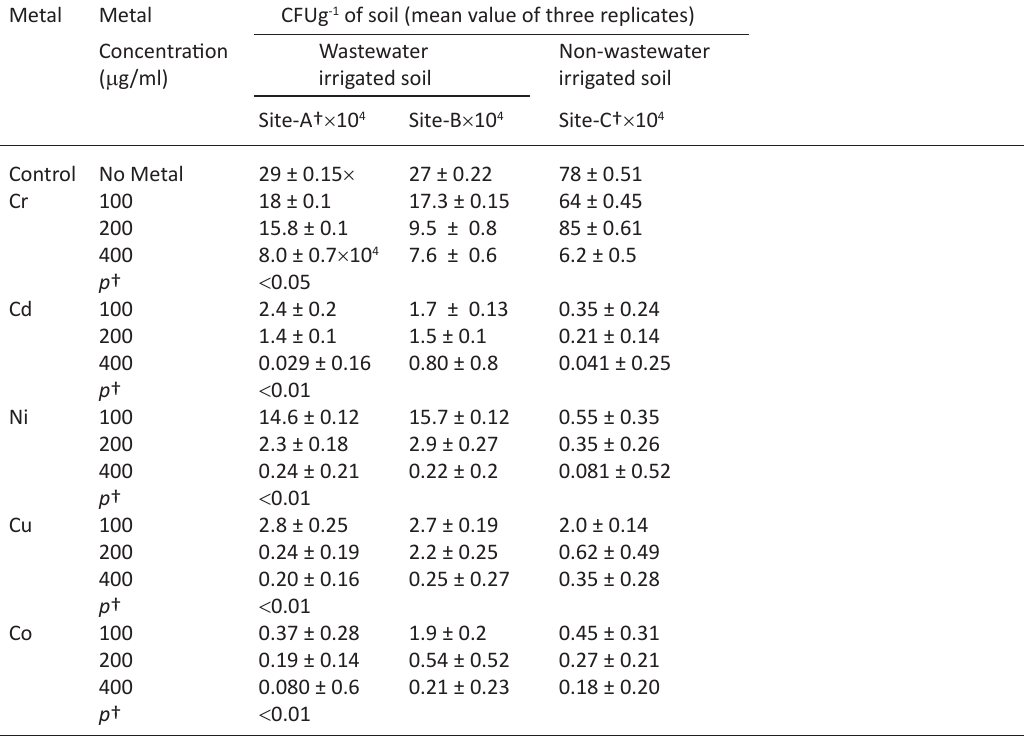
± indicates SD of three replicates p † is the p value from the Wilcoxon test for matched pairs (T test) comparing the metal tolerant fungal populations in contaminated site-A and non-contaminated site-C when 400 µg ml -1 of metal was